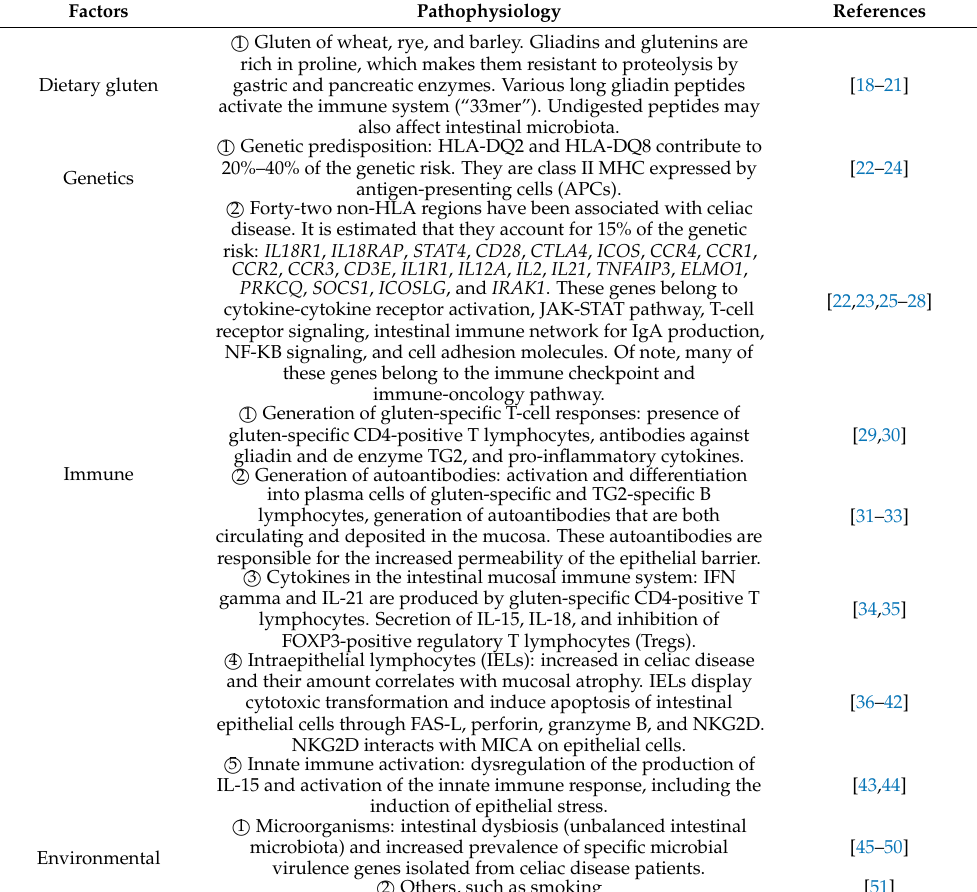
Table 1. Pathogenesis of Celiac